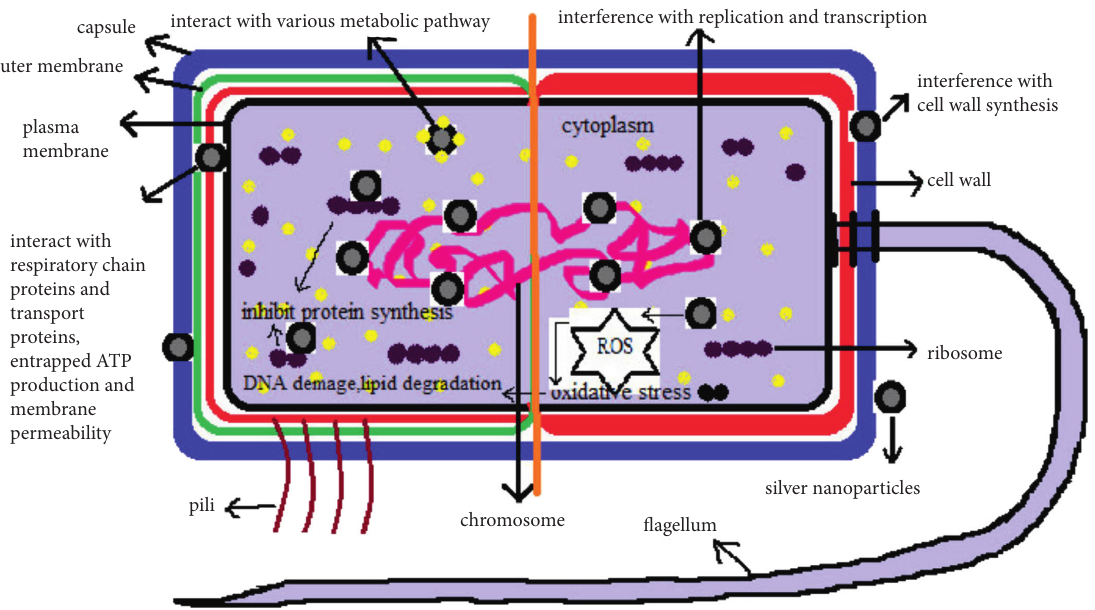
Figure 4: Antibacterial mechanism of silver nanoparticles [87].